Question: Looking at the figure, what chart type is it?
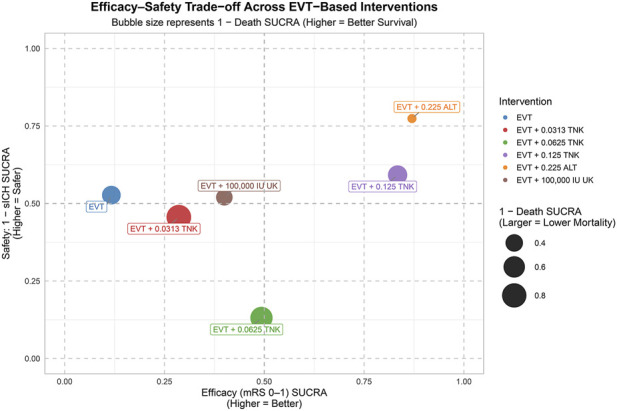
Answer: scatter